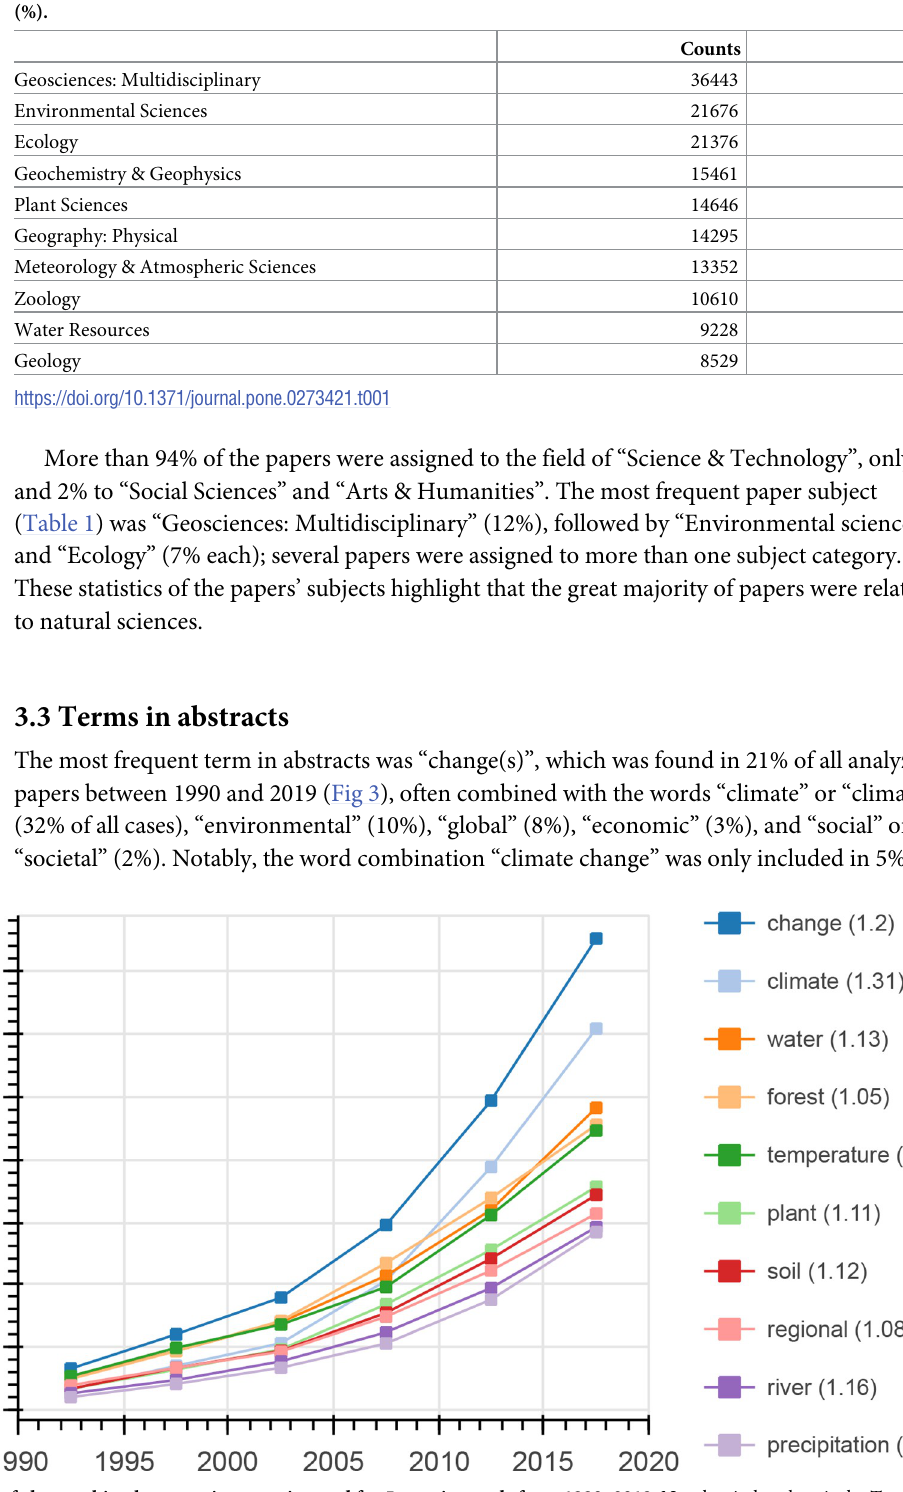
Table 1. The 10 most frequent WOS traditional subjects of mountain papers with absolute hits and relative share (%).